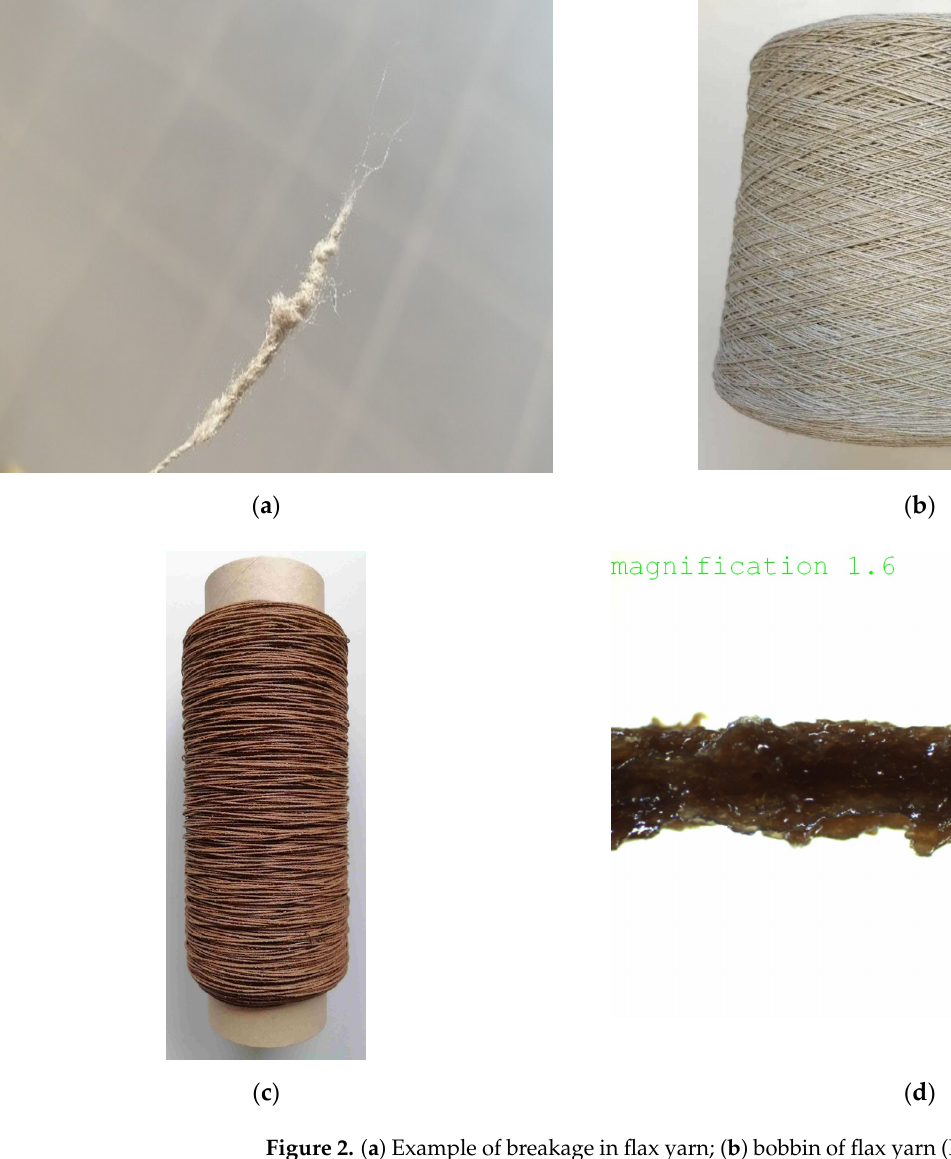
Table 3. Temperature zones of the extruder.